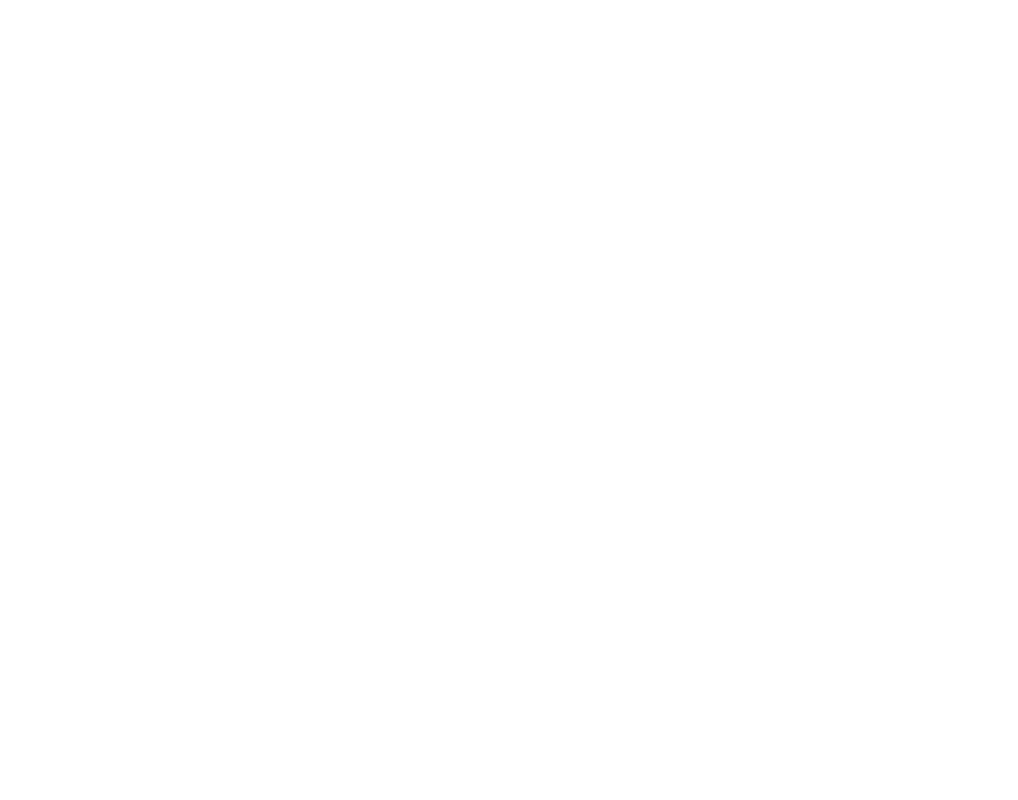
FIGURE 2 | C4d, CD68, and CD3 staining of cardiac allografts. C4d (A) , CD68 (B) , and CD3 (C) staining of cardiac allografts in the NS, PS, and PS + CsA groups at different timepoints after transplantation (n = 5/time point). Magni fi cation: 400×; NS, non-presensitized; PS, presensitized; PS + CsA, presensitized plus cyclosporine